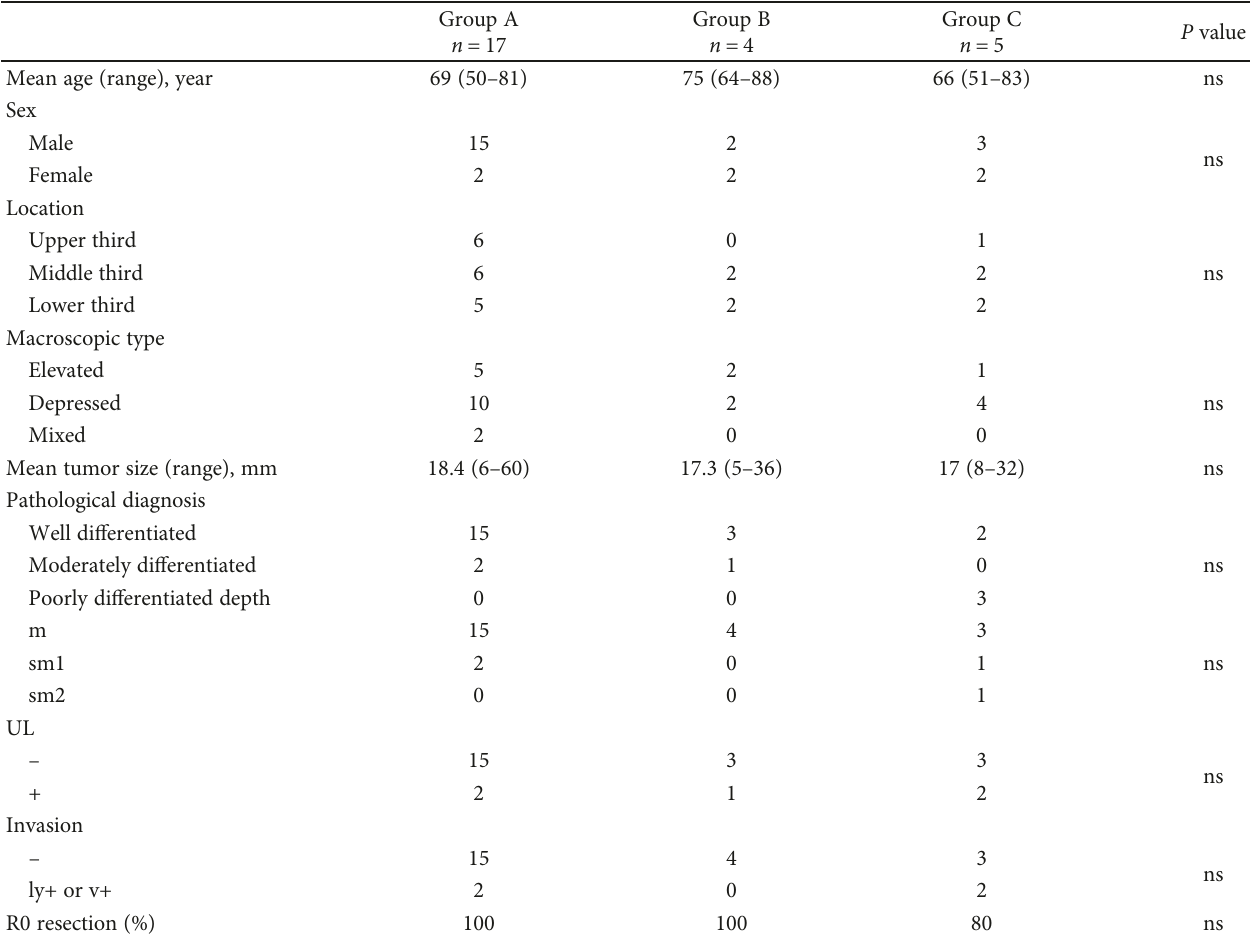
Table 1: Clinicopathological features of early gastric cancers.